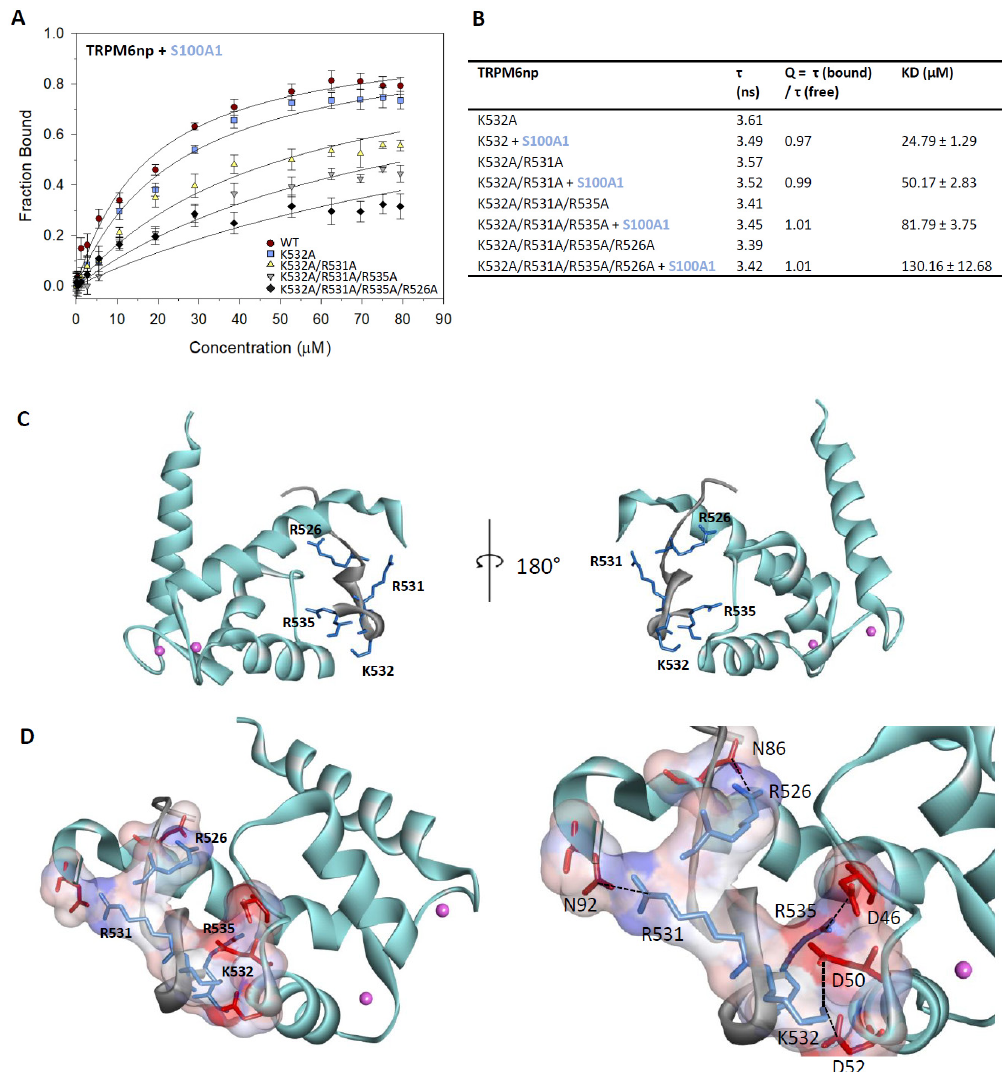
Figure 3. The TRPM6np / S100A1 complex characterisation: ( A ) The bound fractions of FITC-labelled TRPM6np as a function of S100A1 concentration obtained by steady-state fluorescence anisotropy measurement. The F B of FITC-labelled TRPM6np (WT and K532A, K532A / R531A, K532A / R531A / R535A, and K532A / R531A / R535A / R526A mutants) calculated according to Equation (1) was plotted against particular S100A1 concentrations, and the best fit obtained using Equation (2) gave the binding isotherms (WT and mutants appropriate solid lines; see the Methods section). The error bars represent the standard deviation obtained from at least five measurements. ( B ) A summary of fluorescence lifetimes of FITC-labelled TRPM6np-derived mutants K532A, K532A / R531A, K532A / R531A / R535A, and K532A / R531A / R535A / R526A (free and bound); corresponding correction factors; and resultant equilibrium dissociation constants of the TRPM6np / S100A1 complex obtained by steady-state fluorescence anisotropy measurements. ( C ) Top and side view of TRPM6np / S100A1 complex representation: TRPM6np (backbone in grey) and S100A1 (backbone in light blue) composing the binding interface. The basic residues (R526, R531, K532, and R535) of TRPM6np involved in the interactions are shown in blue. Calcium ions are shown in pink as scaled balls representations. ( D ) Full and detailed TRPM6np / S100A1 complex binding interface with surface representation of positively (R526, R531, K532, and R535 from TRPM6np, coloured in blue) and negatively (D46, D50, D52, N86, and N92 from S100A1, coloured in red) charged residues involved in the non-covalent interactions: The colour convention has been used as in the Figure 3C